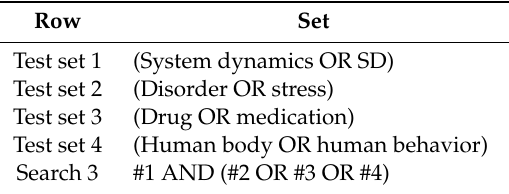
Table 3. The second set of keywords used in the present